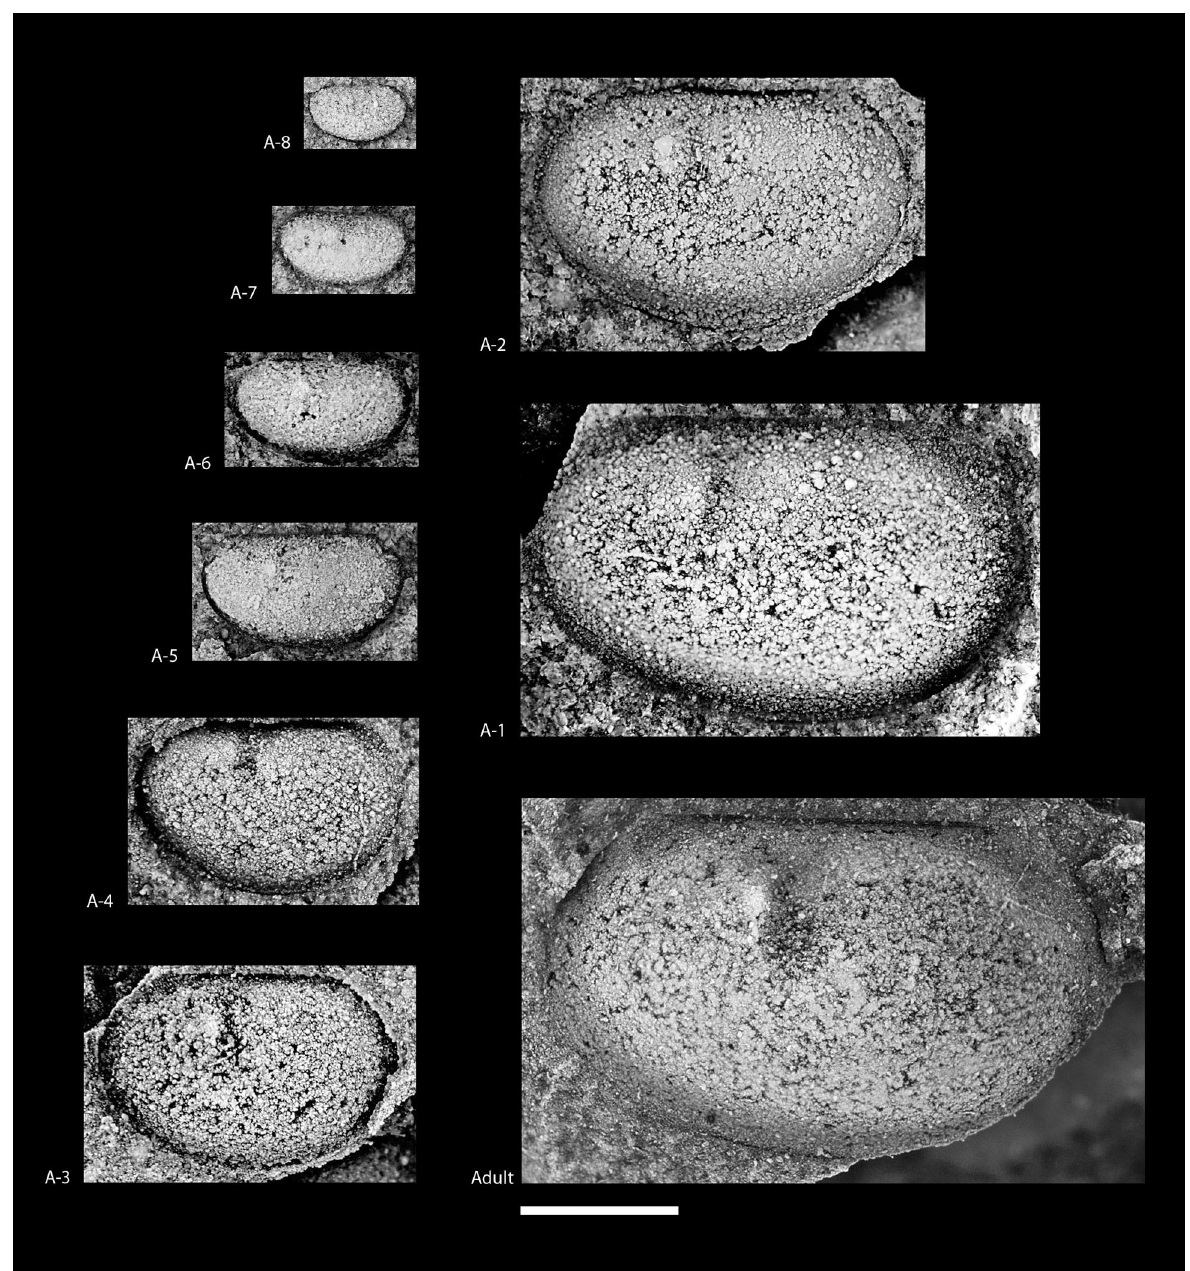
Fig. 3. Ontogenetic stages of Conchoprimitia osekensis , (P ř ibyl, 1979). Ordovician, (cid:138)Ærka Formation. Left valves. A-8 . NM L 35974, locality Osek. A-7 . NM L 36025, locality Osek. A-6 . MBHR 9852, locality T ě (cid:154)kov. A-5 . NM L 36020, locality Ejpovice near Rokycany. A-4 . MBHR 18781, locality D(cid:237)ly. A-3 . MBHR 18831, locality D(cid:237)ly near Rokycany. A-2 . MBHR 6339, locality Osek. A-1 . MBHR 15492, locality D(cid:237)ly near Rokycany. Adult . MBHR 9851, locality D(cid:237)ly. Scale bar equals 1